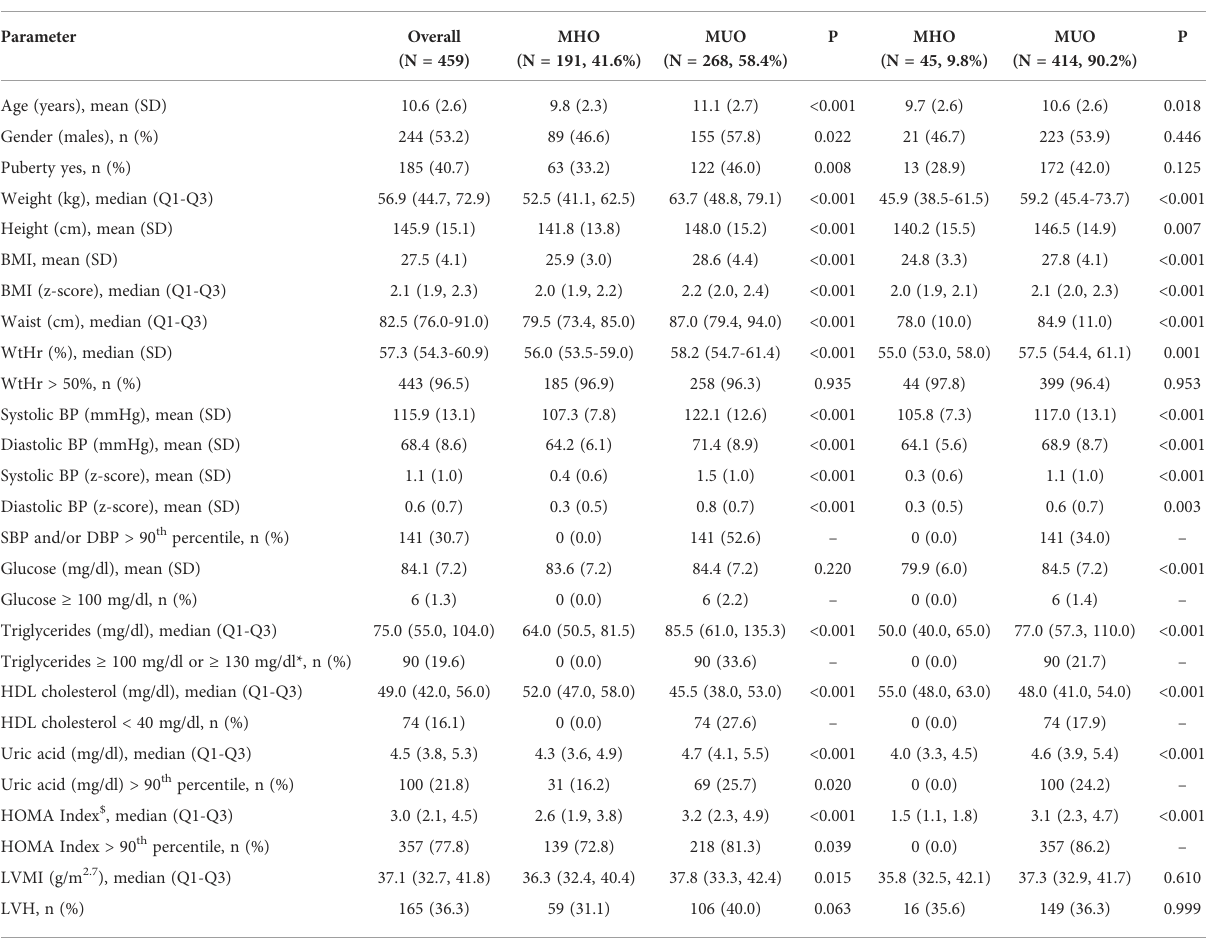
TABLE 1 Anthropometric and clinic characteristics of the study